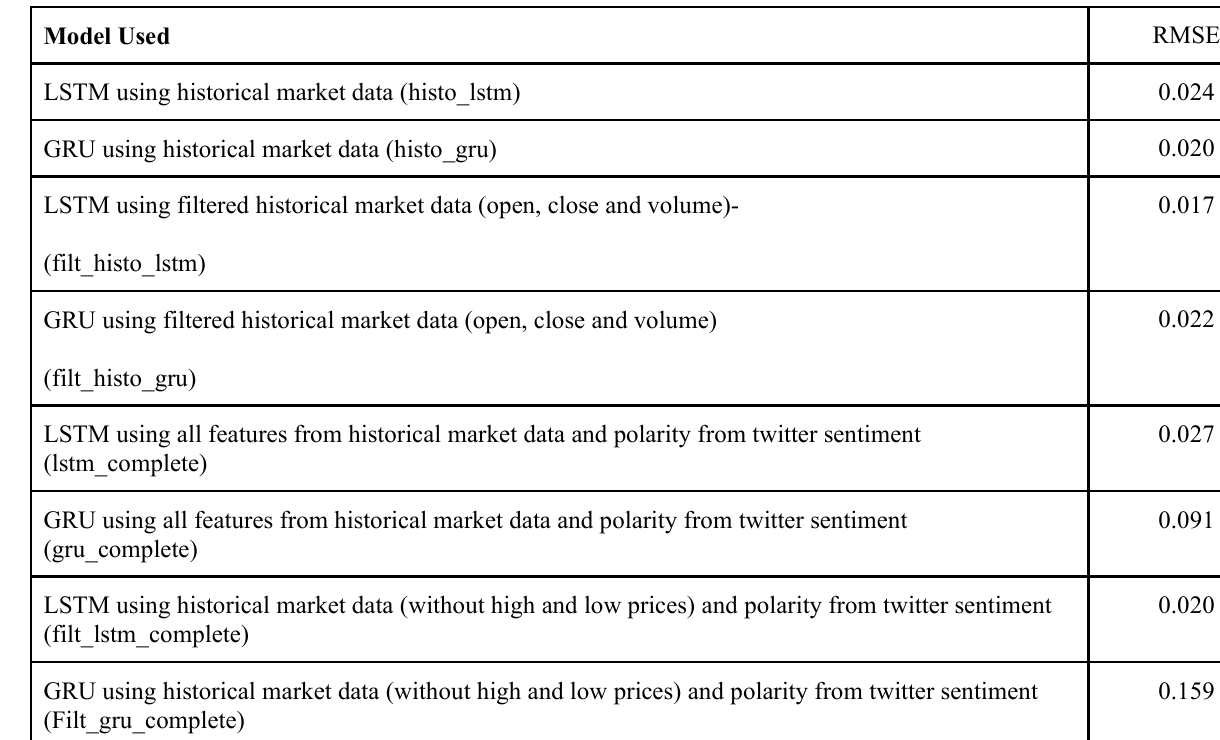
Table 5. Models and their symbolic